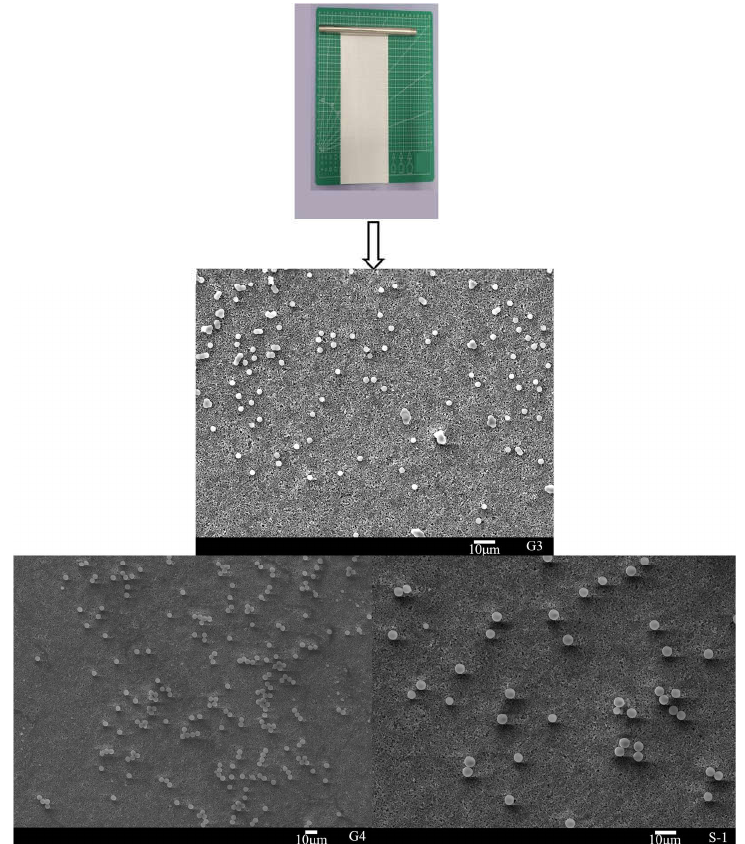
Figure 7. The SEM images of polymer particle adhesives (G3, G4 and S-1) coated onto the battery separator surface by wire rod